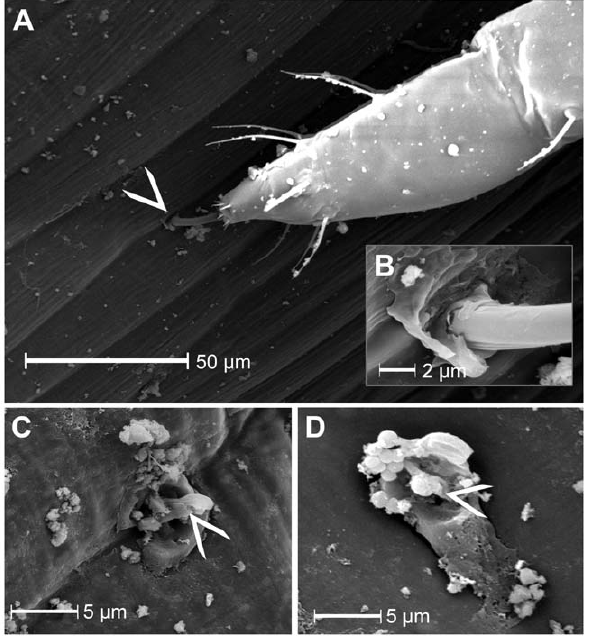
Figure 1. Scanning electron microscopy of stylet penetration sites of M.euphorbiae . A ) The stylet entry point (arrowhead), which always seems to be located at the subsiding rims of anticlinal wall junctions between epidermal cells (N=5), B ) (magnified detail from A ) is surrounded by a salivary flange. The saliva material partially covers the leaf surface around the stylet. C ) After stylet retraction, the salivary flange appears to be plugged (N=10). In the centre of the salivary sheath (arrowhead) saliva material shows a small elevation. Bacteria, spherical structures in the upper left region of the flange, reside on the gel saliva material. Growth of bacteria on the salivary flange material was observed regularly.